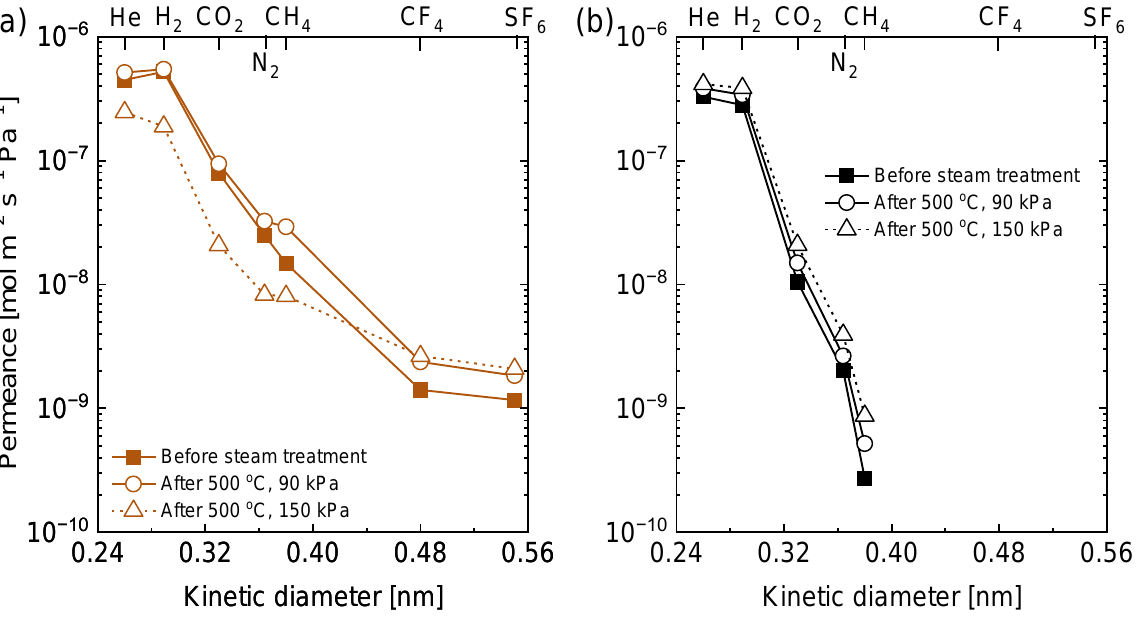
Figure 11. Single-gas permeance as a function of kinetic diameter measured at 300 °C of carbon-SiO 2 -ZrO 2 membranes fabricated at ( a ) 550 and ( b ) 750 °C before and after hydrothermal stability tests at 500 °C with steam partial pressures of 90 and 150 kPa.